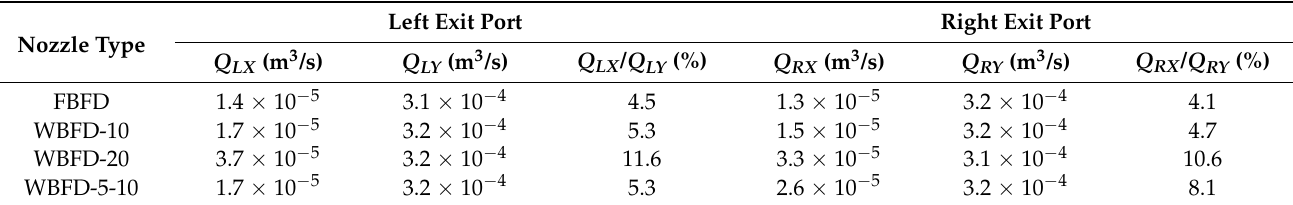
Figure 7 . Hydrodynamic behavior inside nozzles with flow dividers. ( a , b ) Flat bottom, FBFD. ( c , d ) Well depth of 10 mm, WBFD-10. ( e ) Well depth of 20 mm, WBFD-20. ( f ) Well depth of 5 and 10 mm, WBFD-5-10. The letters A and B label the exit ports’ sides. Table 2. Oriented volumetric flows for nozzles analyzed in Figure